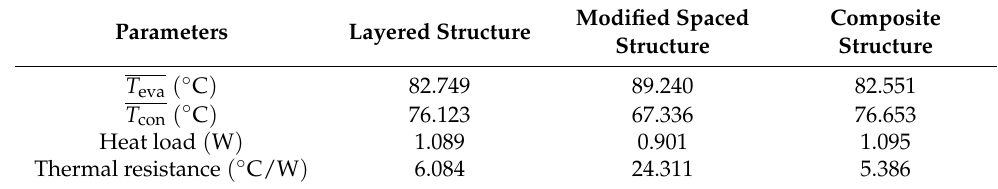
Table 5. Thermal resistance of heat pipes with different internal structures at a cell voltage of 0.45 V.